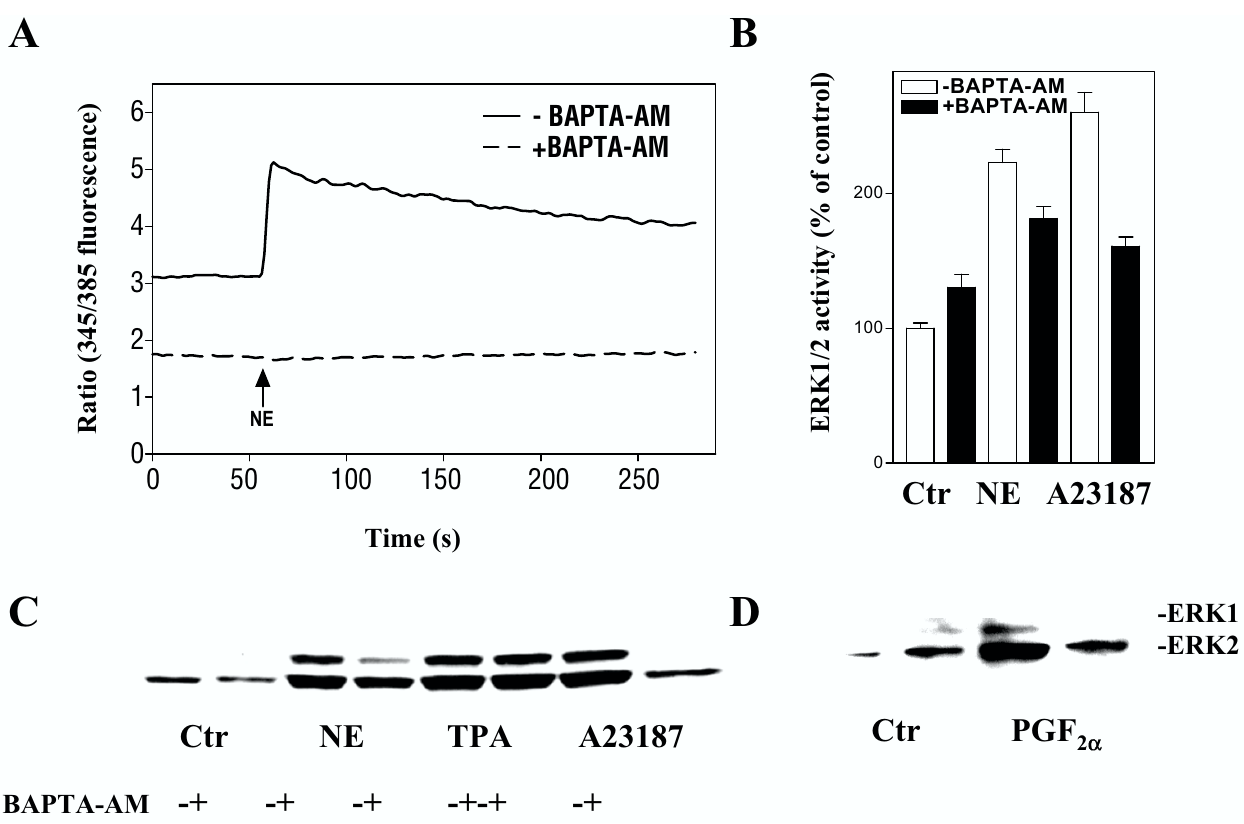
Figure 2 Effect of BAPTA-AM on [Ca 2+ ] i and ERK1/2 activation. A: Measurement of [Ca 2+ ] i . Hepatocytes were preincubated with 0.55 % DMSO or BAPTA-AM (40 µ M) during the last 25 minutes of the fura-2 AM loading. After 60 seconds of registration the cells were stimulated with norepinephrine (10 µ M) in the presence of timolol (10 µ M). Results show a typical single cell response. B-D: ERK1/2 responses. Hepatocytes cultured for 3 h were pretreated for 30 min with BAPTA-AM (40 µ M) in the presence of timolol (10 µ M) prior to stimulation with norepinephrine (10 µ M), A23187 (10 µ M), TPA (1 µ M) or PGF 2 α (10 µ M) for 5 min before cells were harvested. All cultures contained DMSO at a concentration of 0.5 % during the preincubation and a final con- centration of 1 % DMSO during incubation with agonist. B: Activity measurements of ERK1/2 representing mean ± S.E.M.